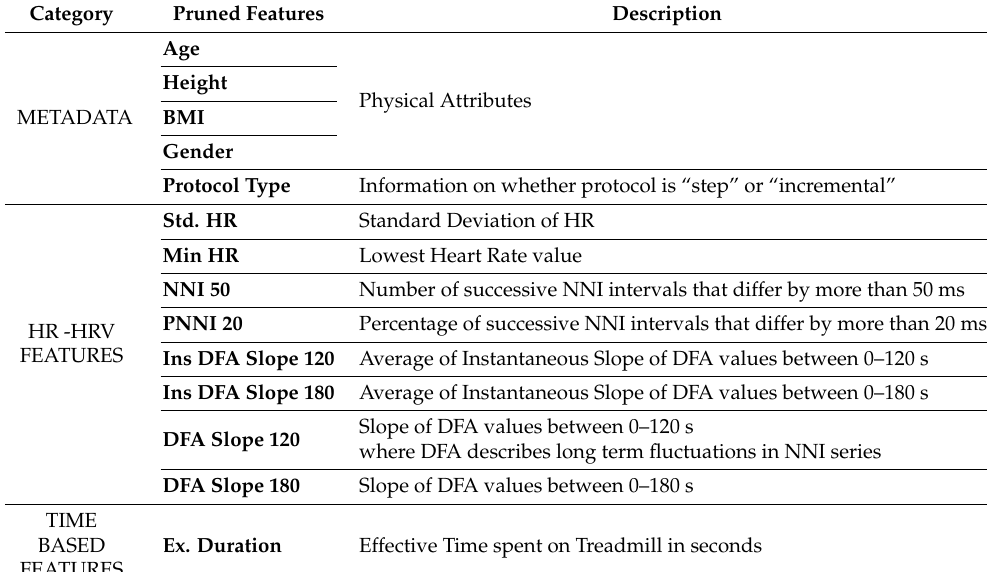
Table 1. Pruned features based on Correlation during Recovery.